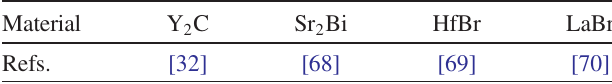
TABLE I. List of experimental syntheses of electride. Material Y 2 C Sr 2 Bi HfBr LaBr